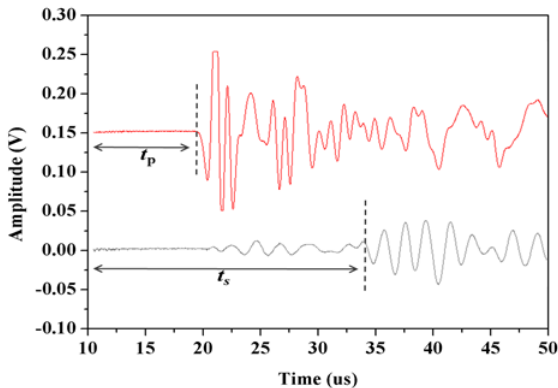
Figure 3. Wave diagram of P and S-wave signals collected in the experiment.